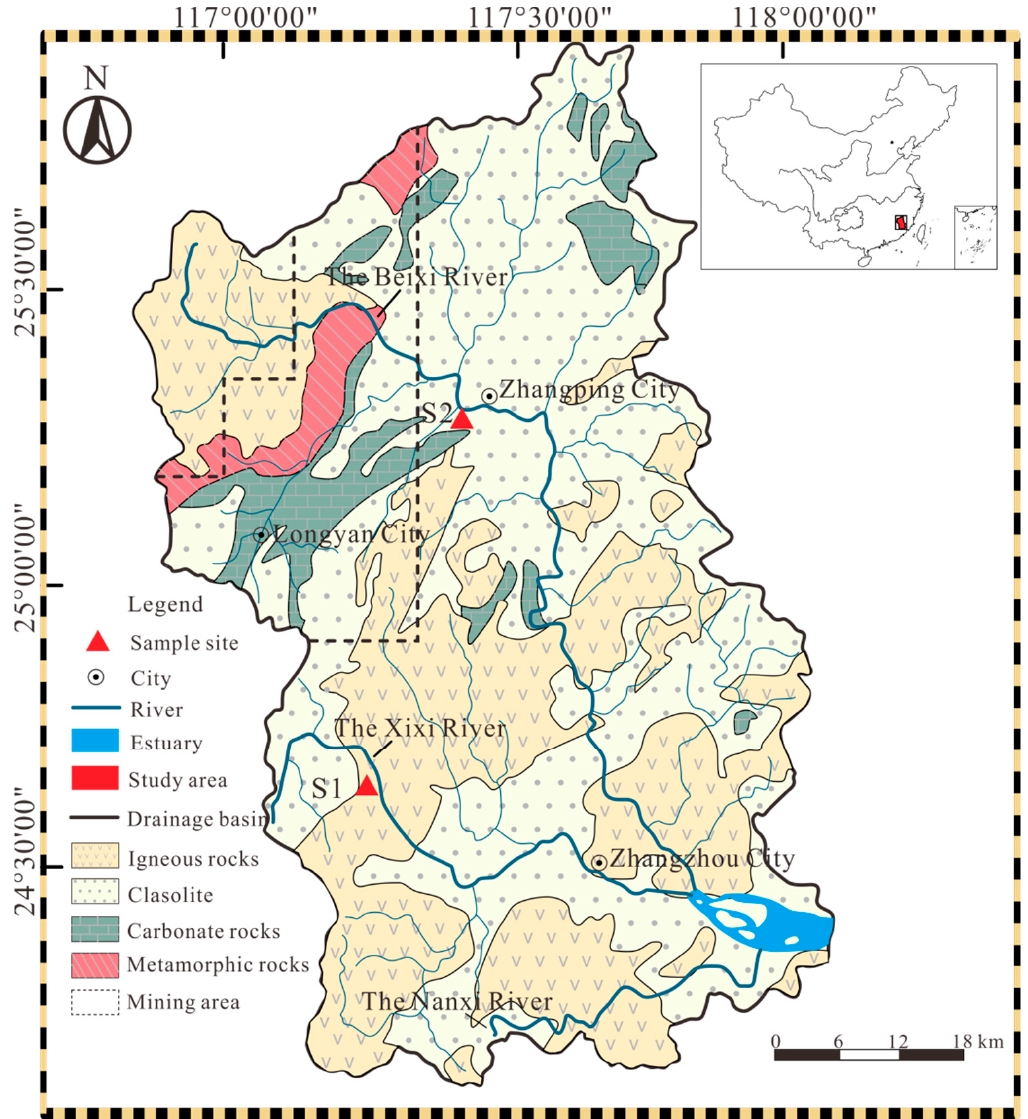
Figure 1. The mining distribution, regional lithology, and location of sampling sites in the Jiulongjiang River.